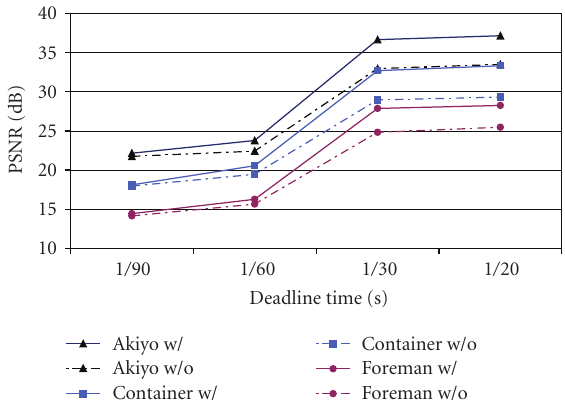
Figure 9: E ff ect of deadline time on received video quality.